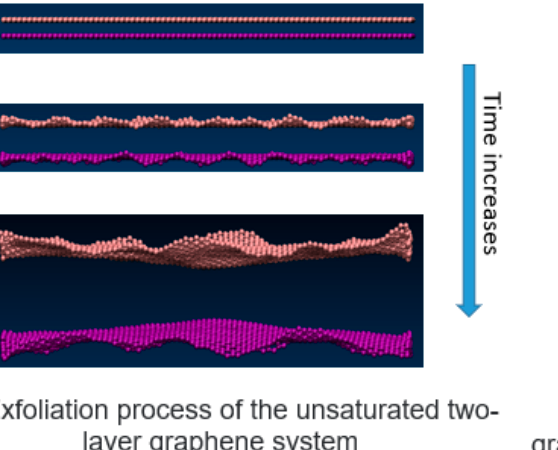
Figure 18. ( a )Exfoliation process of the unsaturated two-layer graphene system, ( b ) exfoliation process of the hydrogen-passivated two-layer graphene system, and ( c ) the total energy of them. 4. Conclusions The exfoliation process of graphene was observed by applying a constant vertical upward velocity to the topmost graphene layer when weakly contacted with SiO 2 sub- strate. In the multilayer graphene system, two critical velocities to exfoliate graphene from the SiO 2 surface were found, and three kinds of distinct exfoliation processes took place determined by critical upward velocities. In the four-layer graphene system, the critical upward velocities were 0.9 Å/ps and 10.23 Å/ps. When V up was smaller than 0.9 Å/ps, it was too slow to generate enough kinetic energy, and four layers can not be exfoliated. By the adhesion from SiO 2 , graphene layers began to sink to the substrate surface. When V up was in the range of 0.9 Å/ps and 10.23 Å/ps, all graphene layers can be exfoliated, four layers went up at the same rate, and the movement curves were parallel. With a V up of more than 10.23 Å/ps, the topmost layer was unbound to the SiO 2 substrate. In two to ten layers graphene systems, the critical velocities to exfoliate all graphene layers (0.5 Å/ps– 3.18 Å/ps) were much lower than that of the topmost layer (9.5 Å/ps–12.1 Å/ps). The critical exfoliate velocity increased with the increasing graphene layers to pull up all the layers. In contrast, the critical exfoliate velocity decreased with the increasing graphene layers to strip the topmost layer. The adhesion force to exfoliate all the graphene layers was 0.0067 nN–0.24 nN in one to ten layers graphene systems. When exfoliating the top- most layer, under Van der Waals forces between the topmost layer and the neighbor layer,